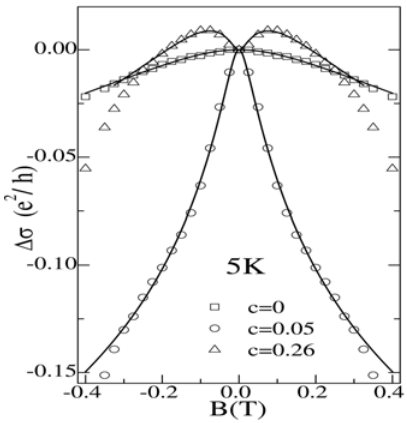
Fig. 6. Experimental points are low-field MC curves observed in thin films of pure Bi (c=0), Bi/Co/Bi trilayer (c=0.05) and [Co/Bi] 10 multilayer (c=0.26), with the field applied perpendicular to film plane. Solid lines are fitting curves produced by